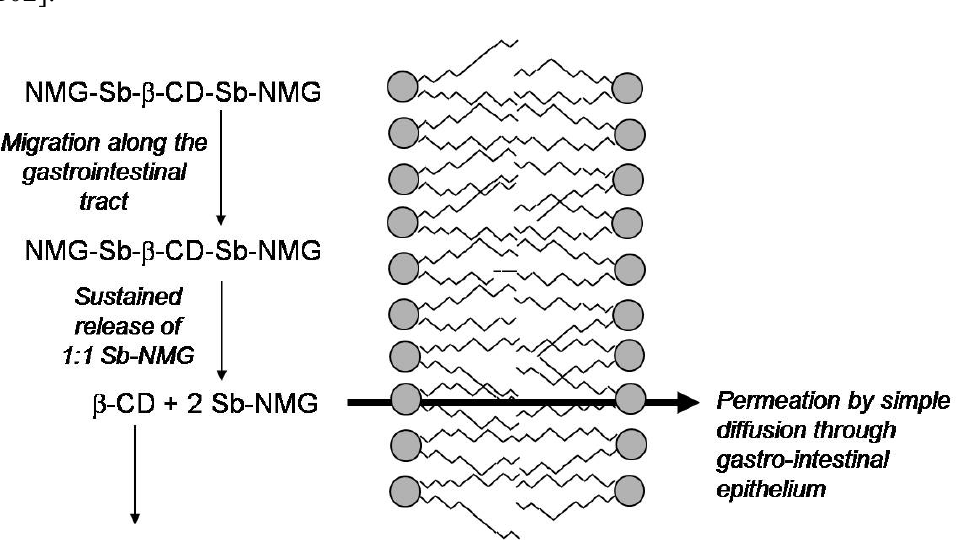
Figure 5. Model proposed for the mechanisms involved in the enhanced absorption of Sb from oral meglumine antimoniate/ β -CD composition. The meglumine antimoniate/ β -CD nanoassemblies comprising high-molecular weight meglumine antimoniate/ β -CD complexes, such as NMG-Sb- β -CD-Sb-NMG species, migrate along the gastrointestinal tract. These nanoassemblies then slowly release meglumine antimoniate in the form of 1:1 Sb-NMG complex which permeates by simple diffusion across the gastrointestinal epithelium. β -CD continue migrating up to the colon where it is degraded. Adapted from Ref.